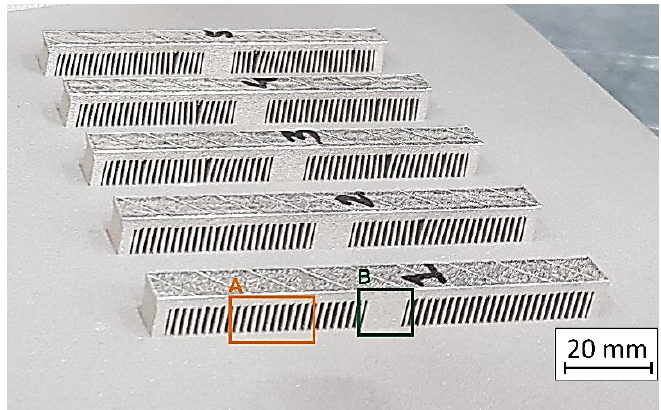
Figure 3. Samples for structural analysis with thin-walled areas ( A ) and a monolithic part ( B ).